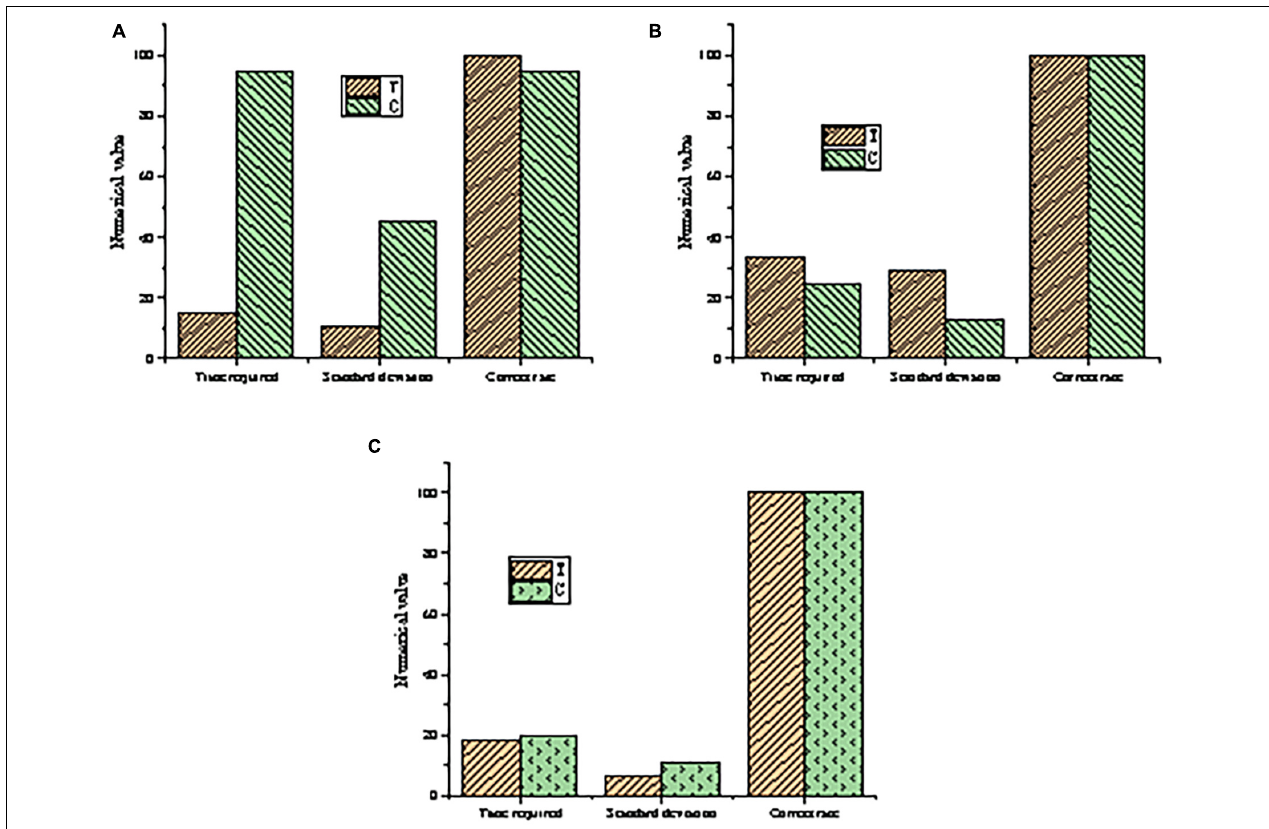
FIGURE 7 | Comparison of testing efficiency (T: test group; C: control group). (A) The testing effect of adding video annotation. (B) The testing efficiency of modifying annotation. (C) The testing effect of commenting on annotation.